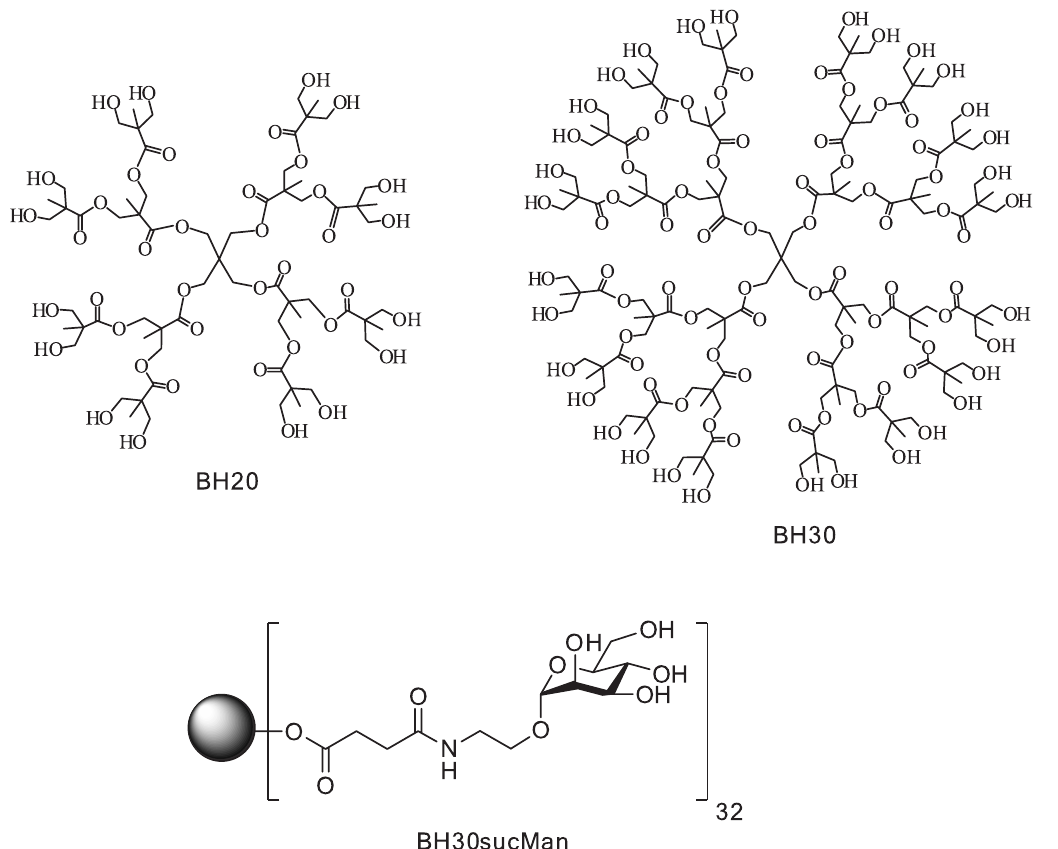
FIGURE 5 - Boltorn hyperbranched structures of 2 nd (BH20) and 3 rd (BH30) generation and the glycodendrimer